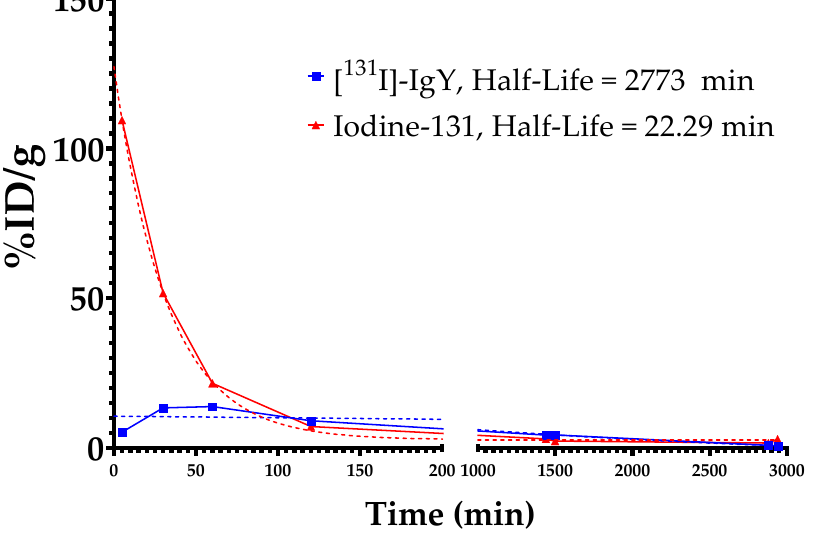
Figure 8. Organ accumulation of [ 131 I]-IgY anti-RBD spike SARS-CoV-2 in normal mice at five time points post intranasal administration, presented as percentage of injection dose per gram of organ (% ID/g).